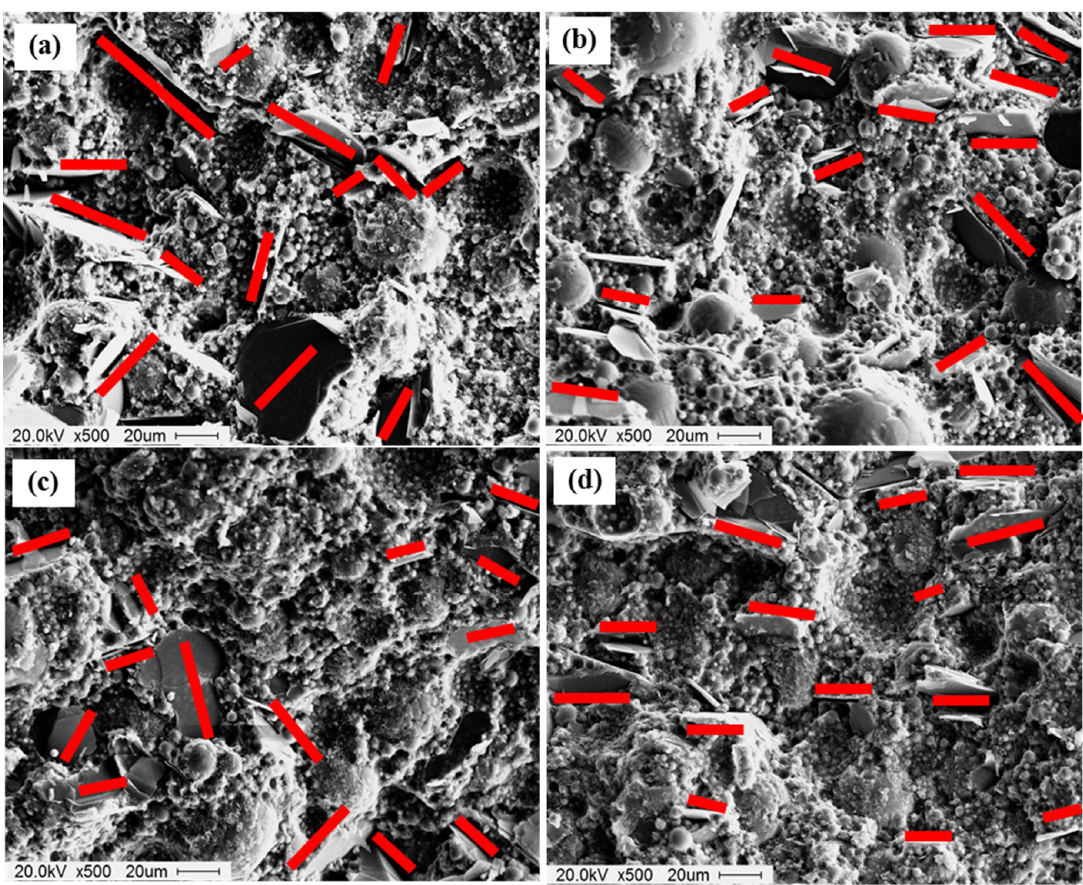
Figure 6. SEM images of Al 2 O 3 /EP filled with ( a ) 3.63 vol %, ( b ) 4.30 vol %, ( c ) 5.32 vol %, and ( d ) 6.32 vol % boron nitride.